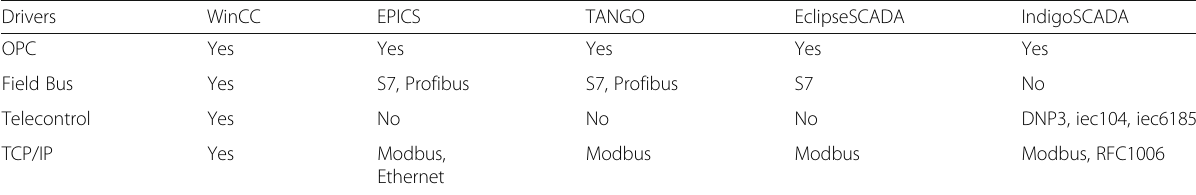
Table 1 Comparison of supported SCADA drivers